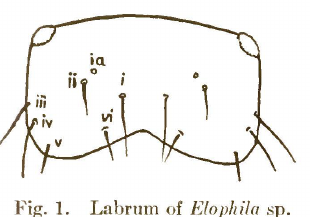
Fig. 1. Labrum of Elophila sp. is rather farther out. Lower lip normal. Apparently there are only three ocelli, but the specimen is not faYorable. Prolegs as